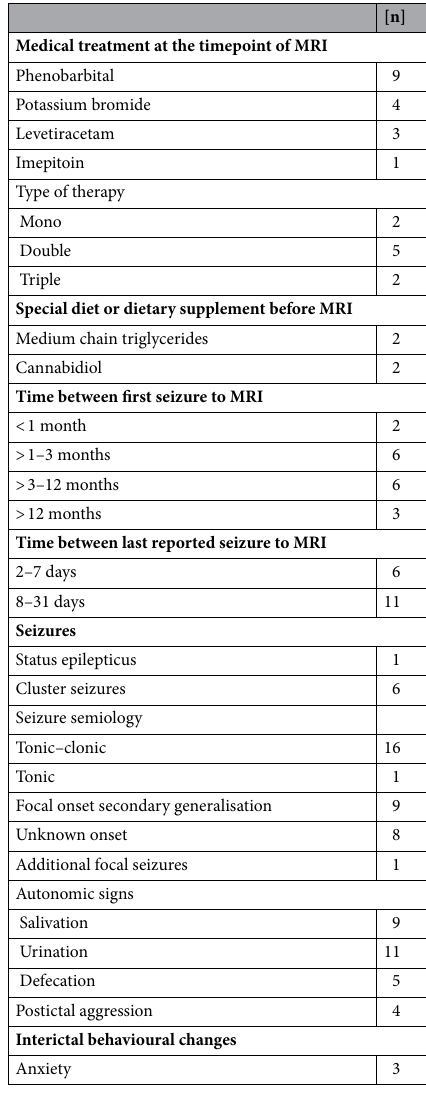
Table 2. Semiology of epileptic events in the affected